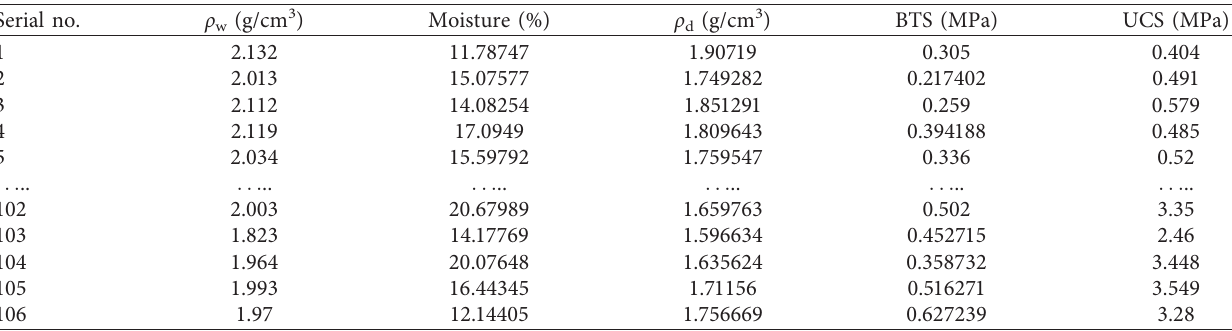
Table 2: Brief summary of UCS